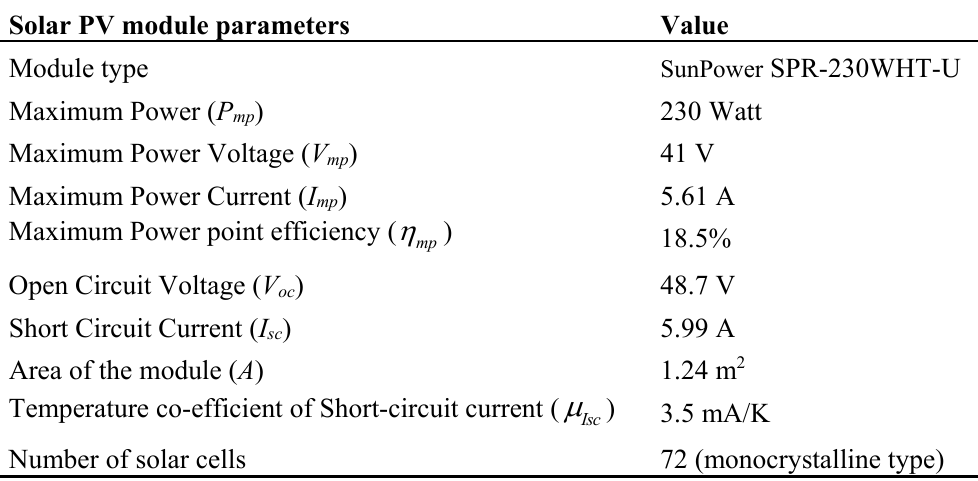
Figure 8. Schematic Diagram of V-trough PV system. Table 2. Specifications of the SunPower 230 PV